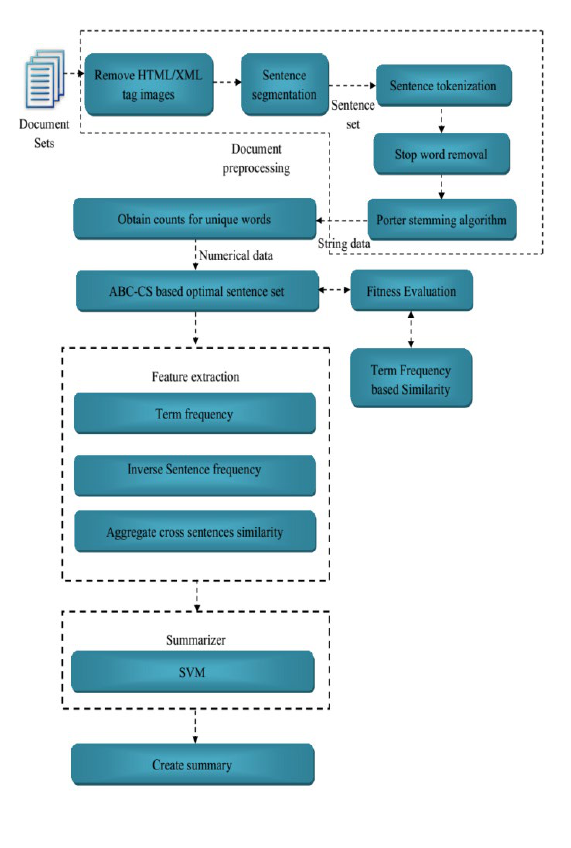
Figure 2. Schematic Diagram of proposed document summarization